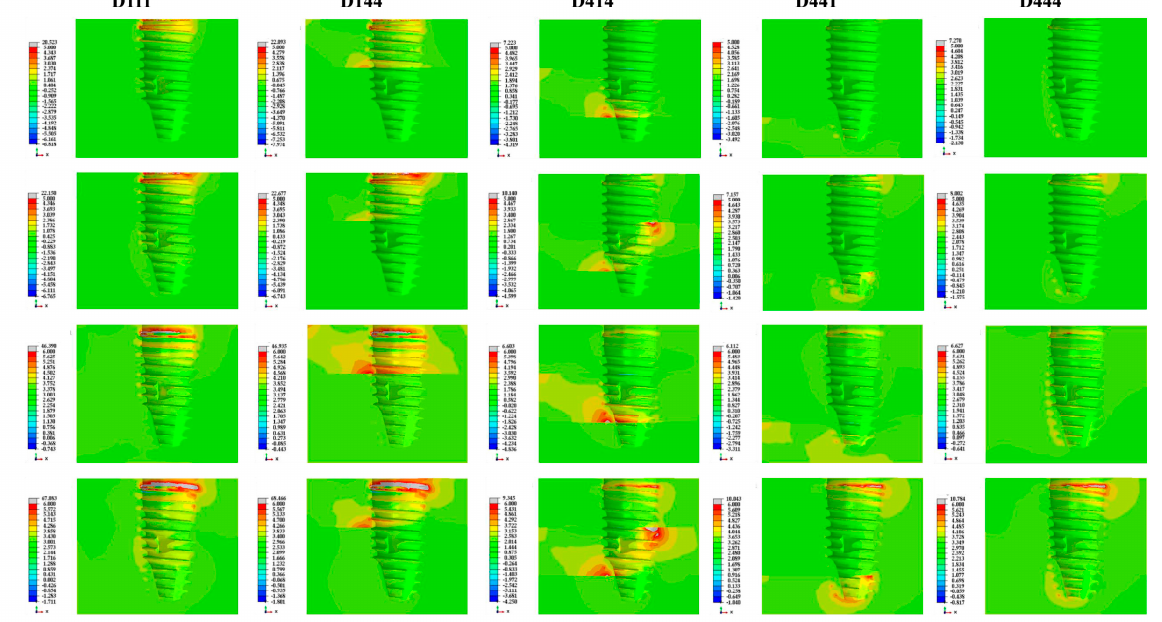
Materials 2023 , 16 , x FOR PEER REVIEW Figure 5. Cross-sectional view of the maximal principal stress values for the 5 bone densities and 2 surgical techniques under 100 N axial load and 30 N oblique load.